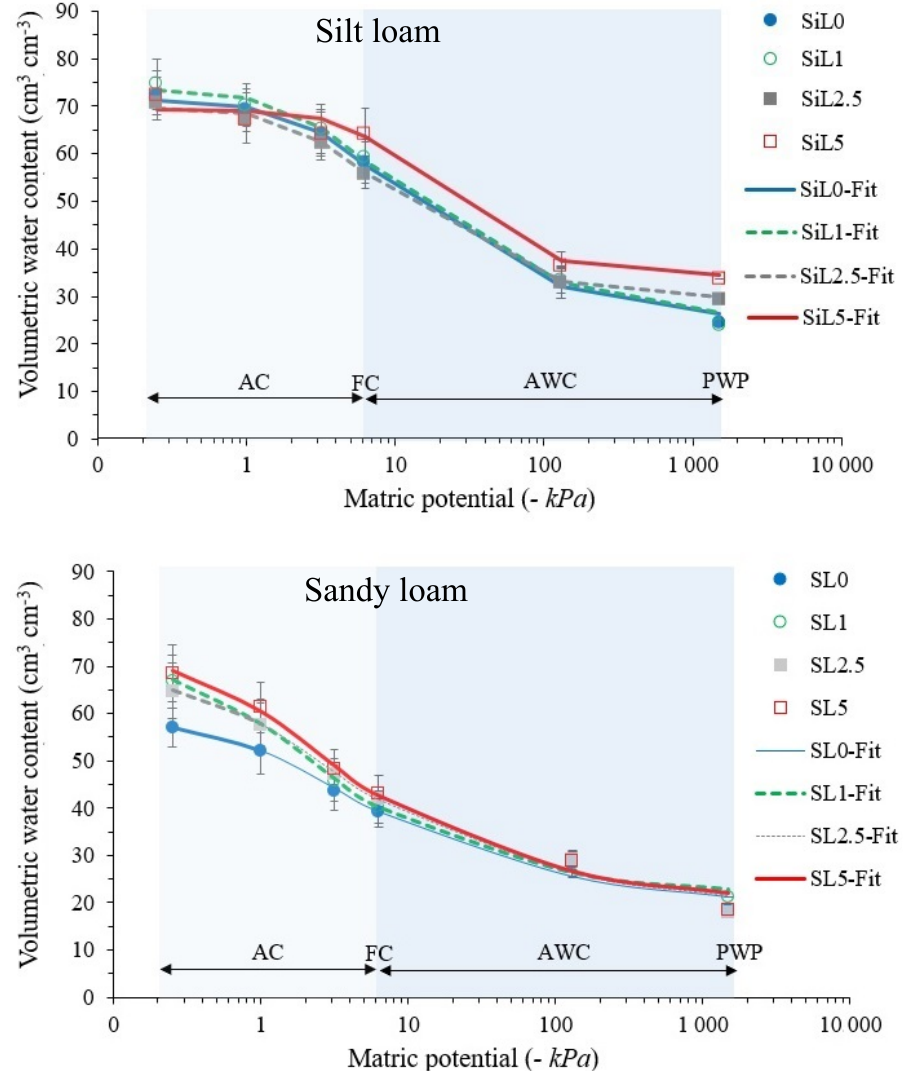
Figure 5. Water retention curve for the silt loam (SiL) and sandy loam (SL) materials and their mixtures with 1, 2.5, and 5 wt.% bamboo biochar. Observed data were fitted with the van Genuchten– Mualem model by means of the RETC software [46]. Table 4. Soil hydraulic fitted parameters based on the van Genuchten–Mualem model ( m = 1 − 1/ n ), shown in Figure